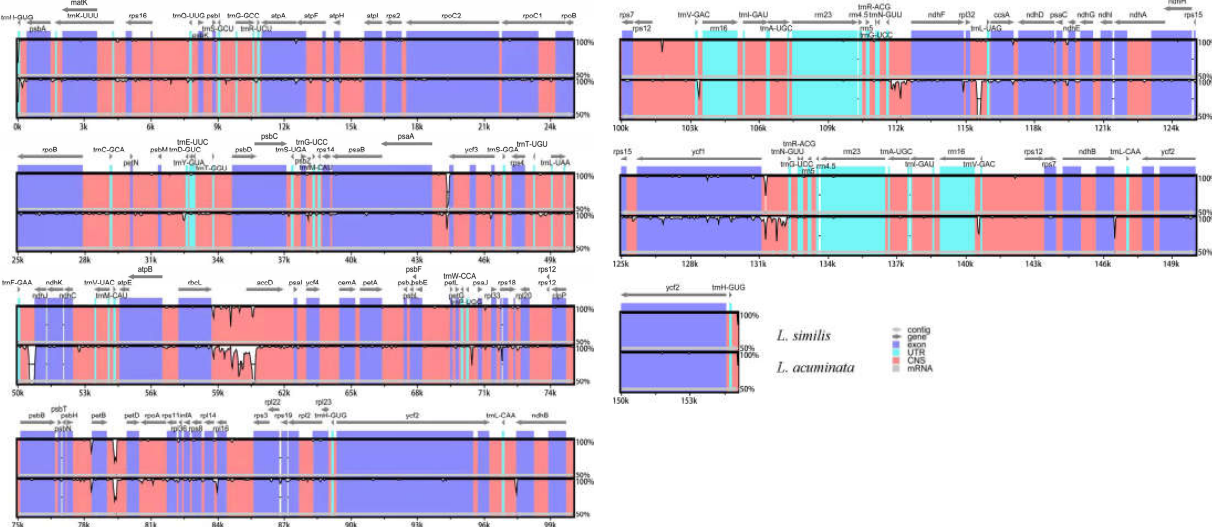
Figure 5. Sequence alignment of three chloroplast genomes in the Caprifoliaceae family performed with mVISTA using annotation of L. japonica as reference. The top arrow shows transcription direction; genome regions are color coded as exon, Untranslated Region (UTR), mRNA, and conserved non-coding sequences (CNS).The x -axis represents the coordinates in the cp genome while the y -axis represents percentage identity within 50–100%.